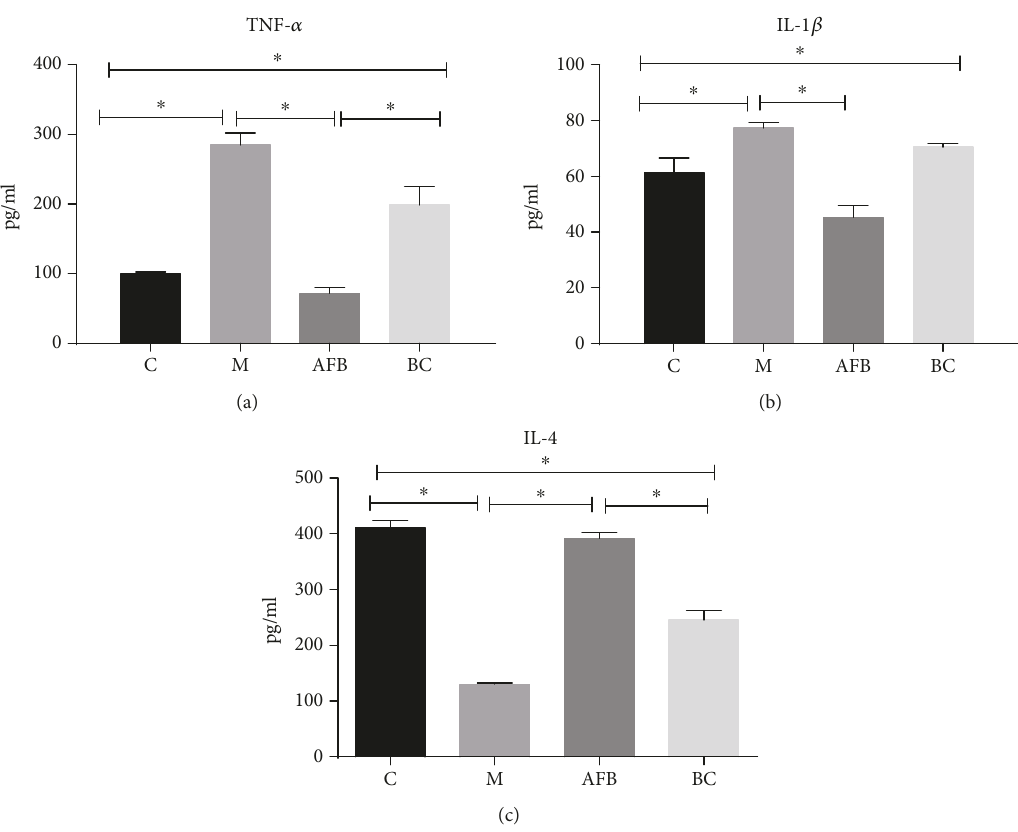
Figure 3: E ff ect of the aloe-fermented liquid on the production of in fl ammatory TNF- α (a), IL-1 β (b), and IL-4 (c) in the blood using the ELISA method. C, control group; M, model group; AFB: aloe-fermented liquid group; BC: burn cream group. Data are shown as the mean ± SD. ∗ p < 0 05